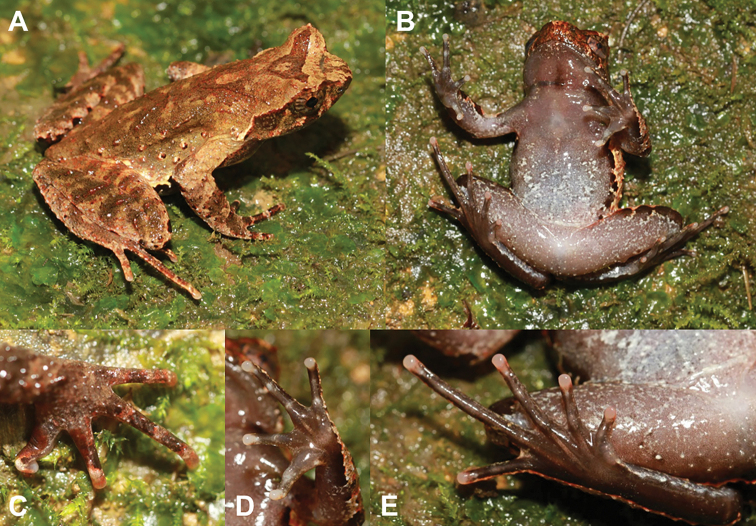
Photos of the holotype CIBCS20190518031 of Megophrys
chishuiensis sp. nov. in life A dorsal view B ventral view C dorsal view of hand D ventral view of hand E ventral view of foot.